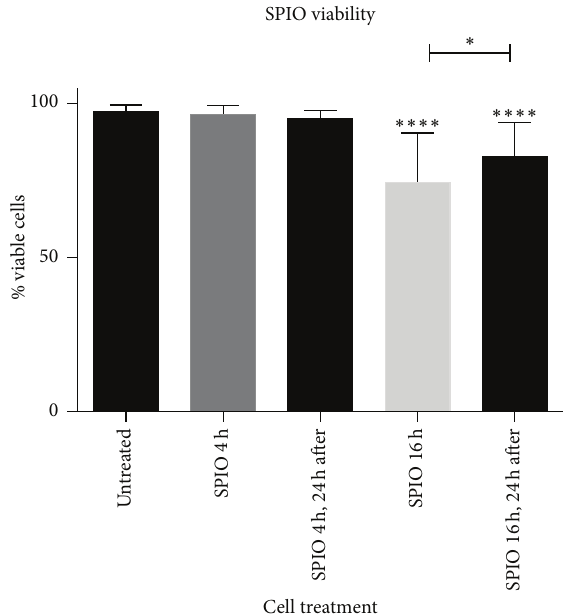
Figure 1: Cell Viability . Shown after labeling with SPIOs for 4 or 16 hours as compared to untreated cells. Measurements were recorded immediately and 24 hours after treatment ( ∗∗∗∗ 𝑝 < 0.0001 , ∗ 𝑝 < 0.05